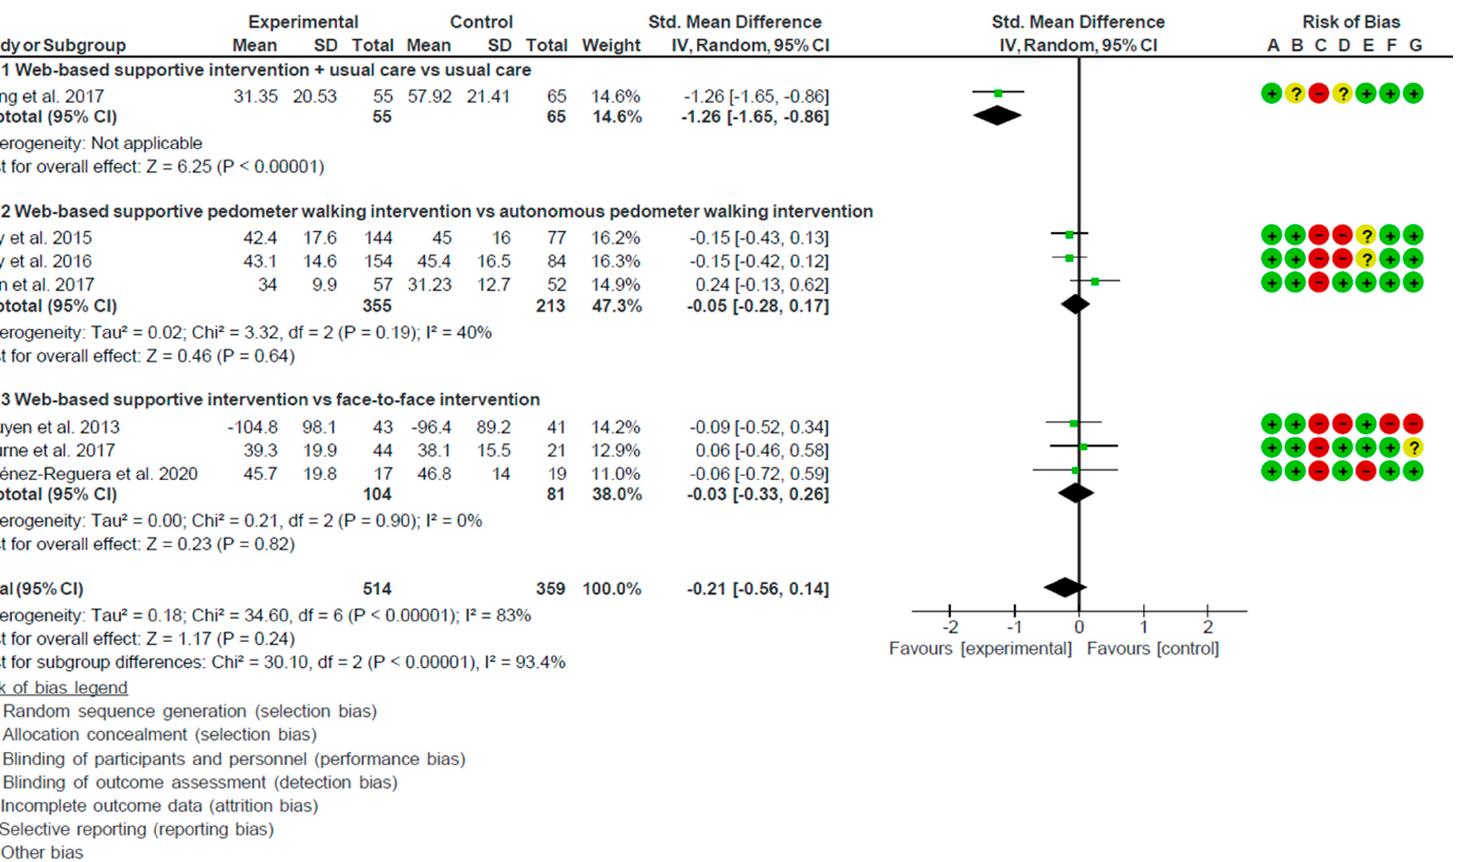
Figure 3. Forest plot of the effect of web-based supportive interventions on quality of life in COPD patients compared with the control group. Notes: Risk of bias color: red, high risk of bias; yellow, moderate risk of bias; green, low risk of bias.